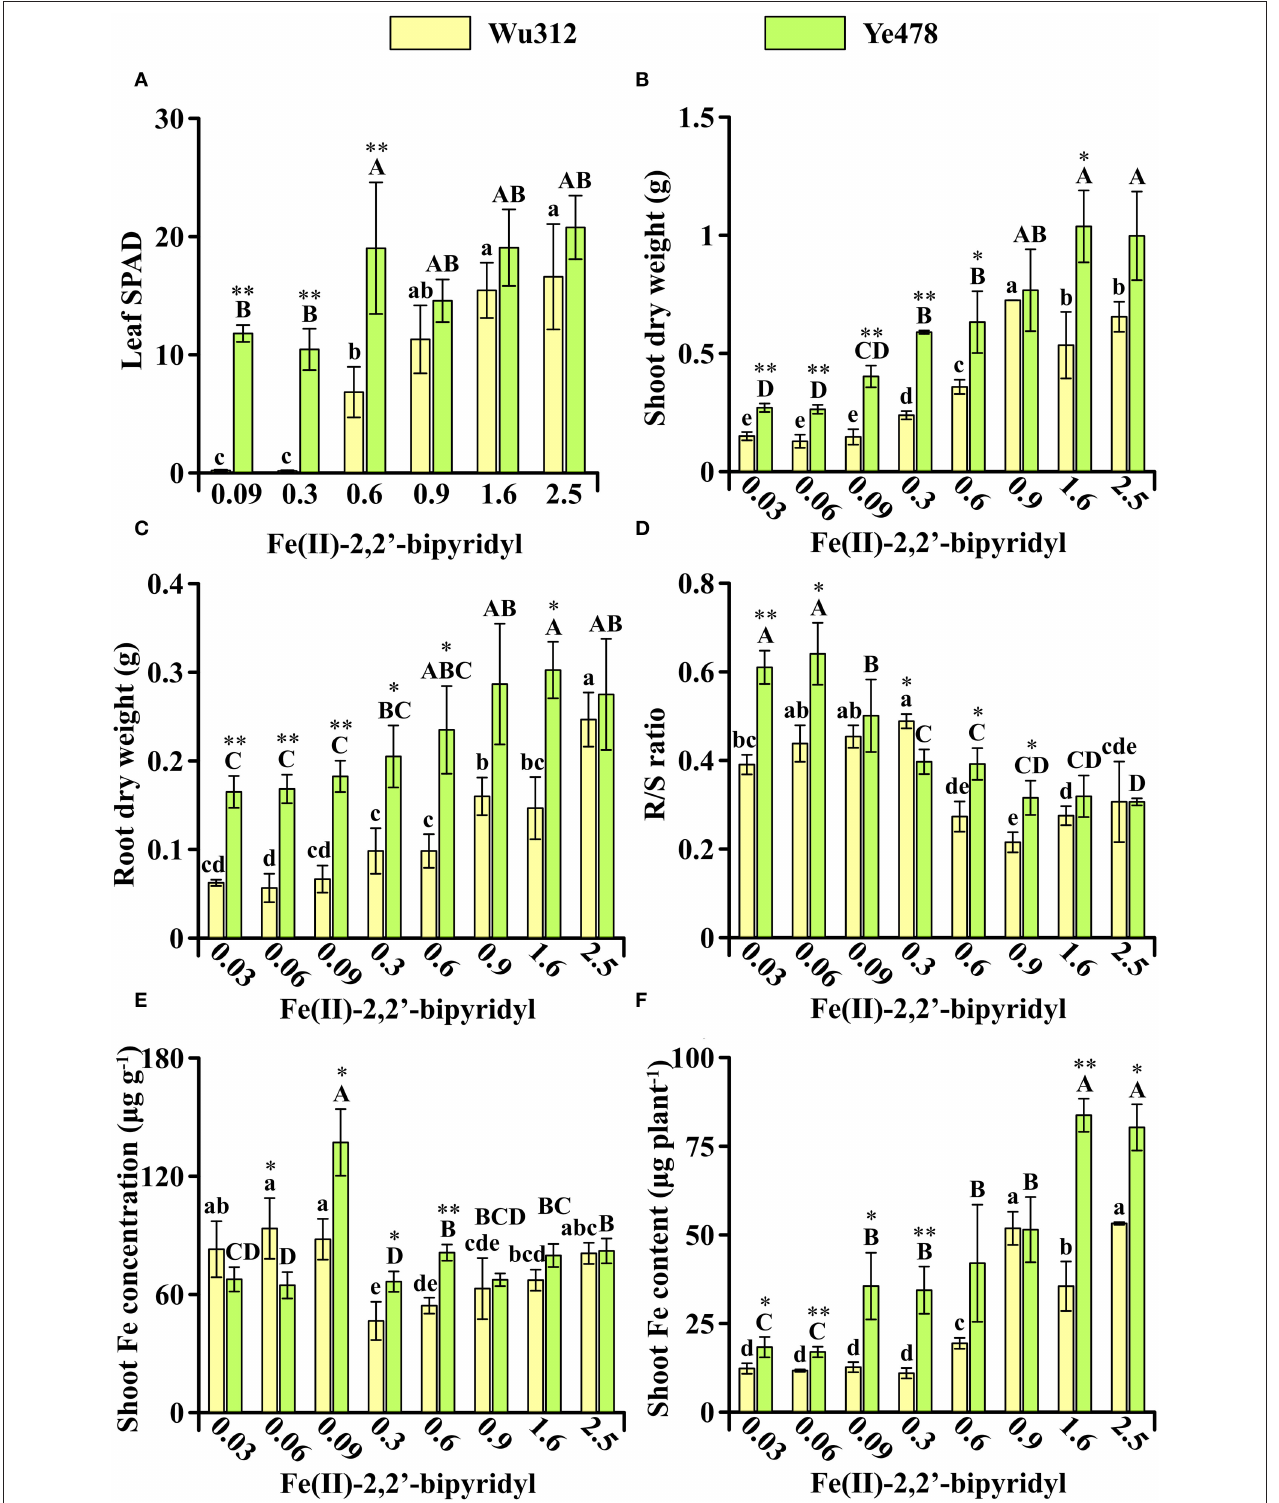
FIGURE 3 | Effects of different Fe supply levels on plant growth of Wu312 and Ye478 during different periods in Experiment 2. (A) Leaf SPAD; (B) shoot dry weight; (C) root dry weight; (D) R/S ratio; (E) shoot Fe concentration; (F) shoot Fe content. Different lowercase (uppercase) letters indicate significant differences in Wu312 (Ye478) among different treatments at P < 0.05. * and ** indicate significant differences between Wu312 and Ye478 in the same treatment at P < 0.05 and P < 0.01, respectively.